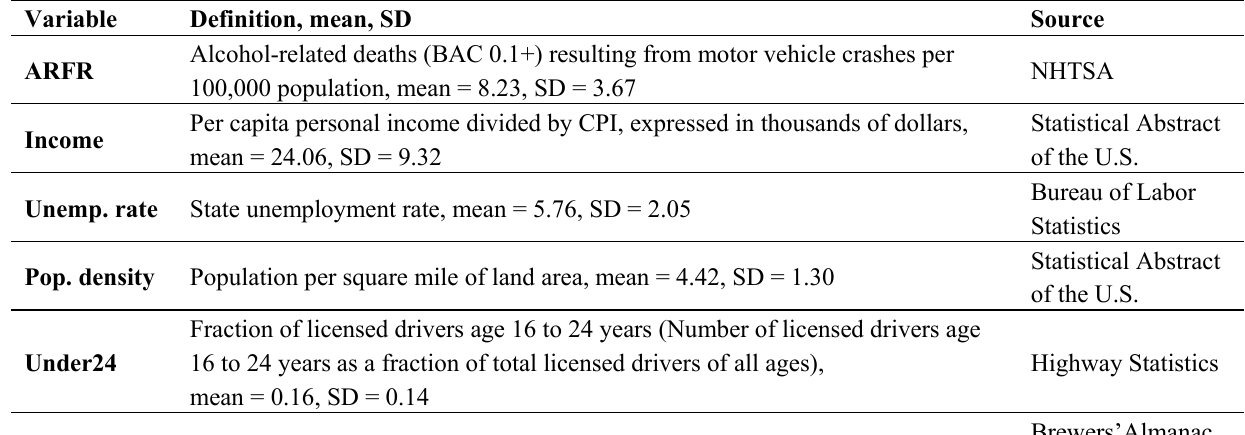
Table 1. Variable definition and